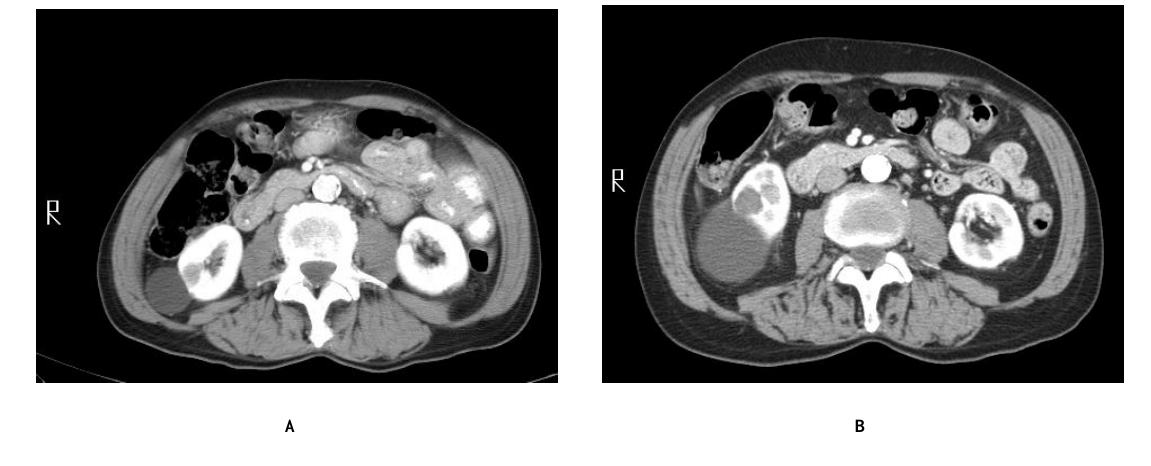
FIGURE 1. CT imaging of right renal mass. (A) 2002, (B)